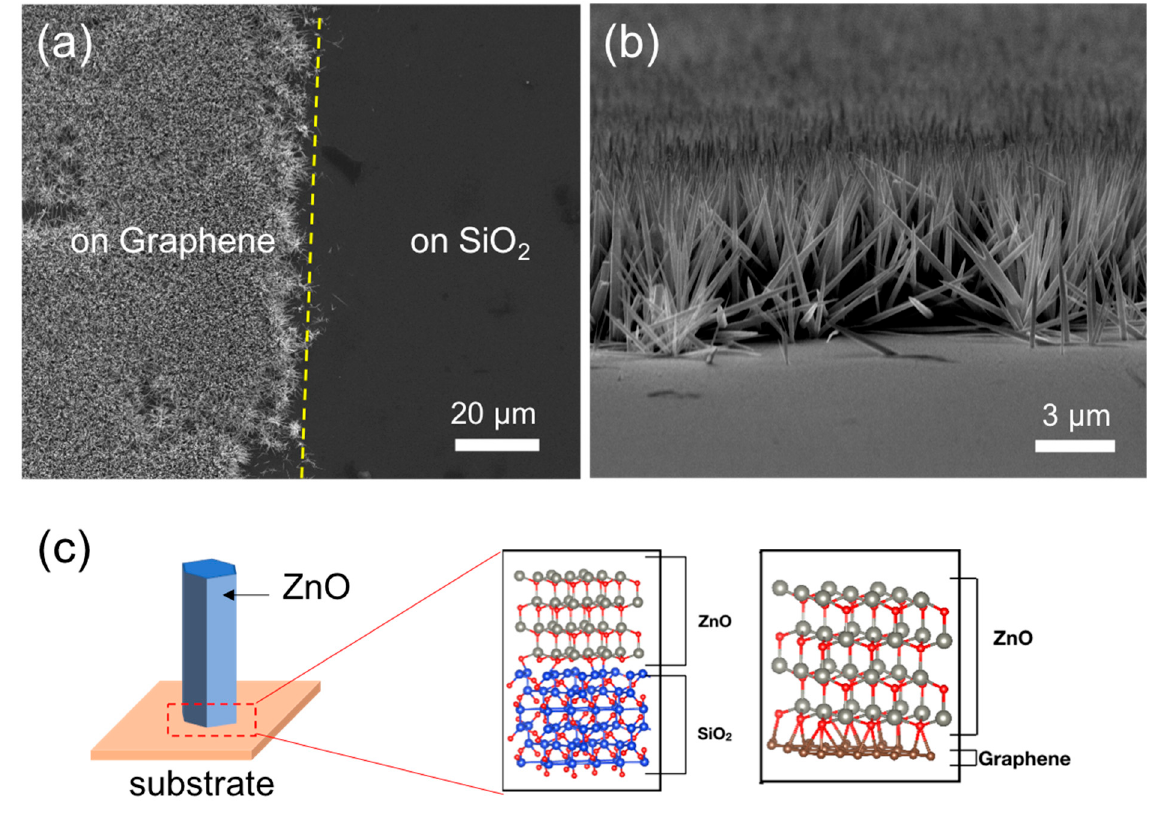
Figure 1. ( a ) Top-view and ( b ) tilted-view SEM images of ZnO wires grown on graphene. ( c ) The supercells composed of ZnO, SiO 2 , and graphene for the DFT calculations.